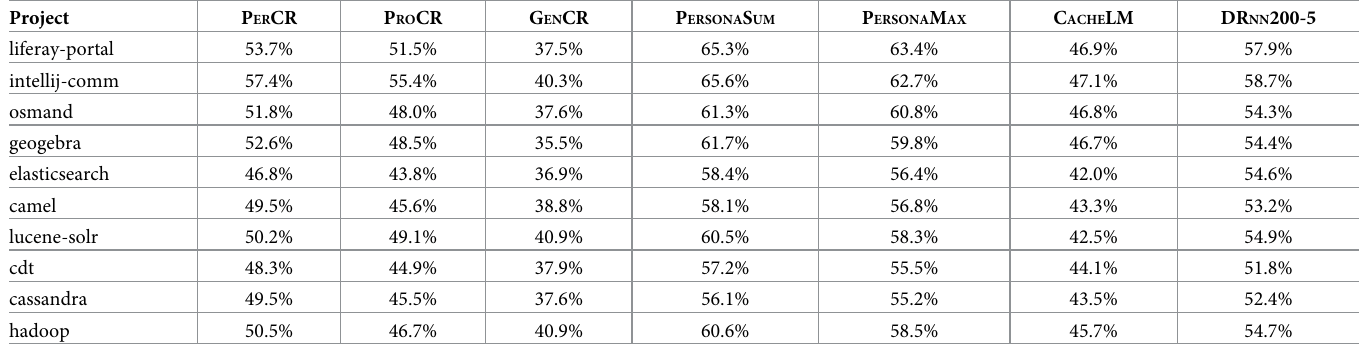
Table 5. Recommendation accuracy of top-contributed programmers in selected